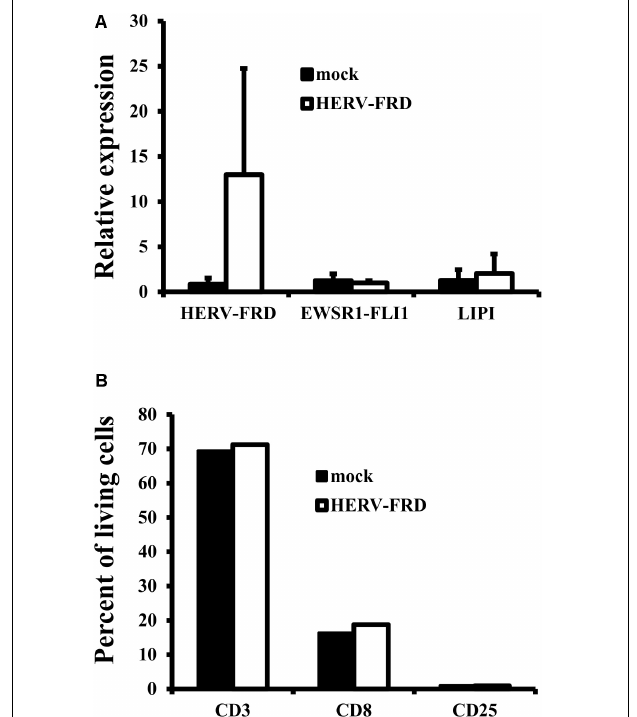
FIGURE 4 | Absence of immunomodulatory effects of HERV-FRD transfected A673 cells. A673 cells were transfected with HERV-FRD or with empty vector (mock). (A) RNA from transfected cells were analyzed for presence of HERV-FRD and the Ewing sarcoma specific transcripts EWSR1-FLI1 and LIPI . (B) Transfected cells were used as stimulatory cells in mixed lymphocyte/tumor cell cultures. Stimulated cells were analyzed for presence of T cells (CD3), cytotoxic T cells (CD8), and activated lymphocytes (CD25). Presented are means and standard deviations from three independent